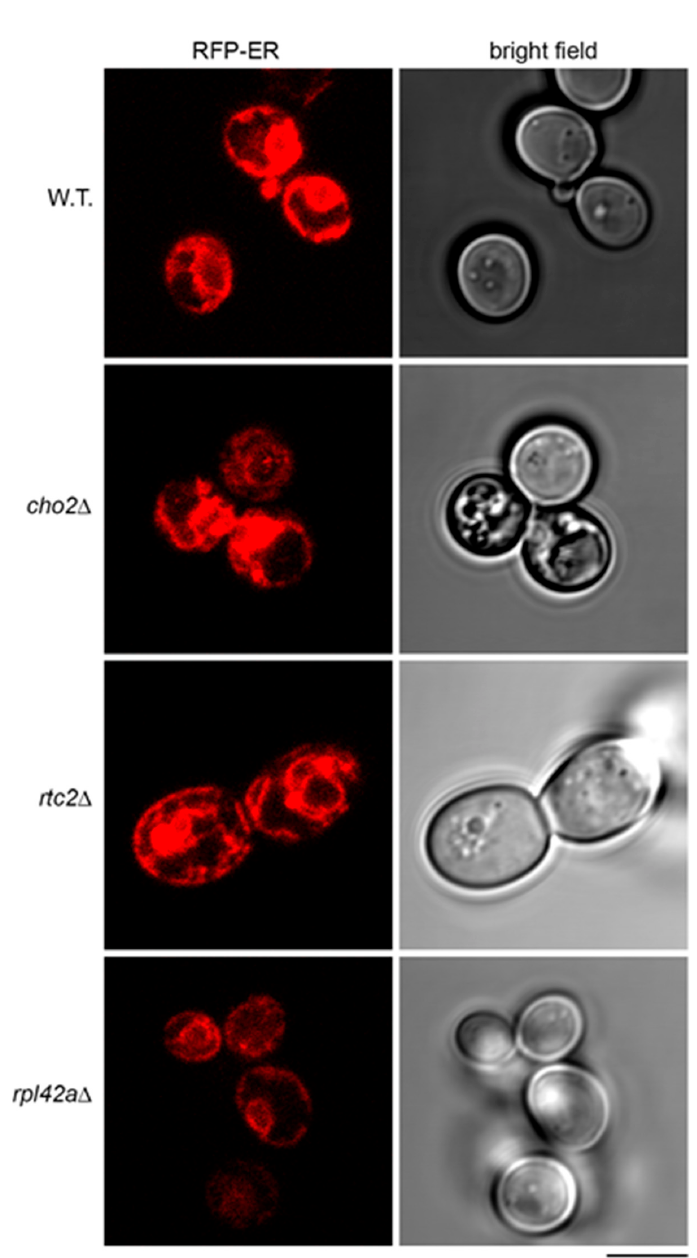
Figure 7. Endoplasmic reticulum of the mutants accumulating the model RNA shows deviations from the wild type. Live-cell imaging of wild-type (BY4741, W.T.) and mutant strains (indicated on the left) transformed with the plasmid expressing RFP-ER. Scale bar is 5 µm.